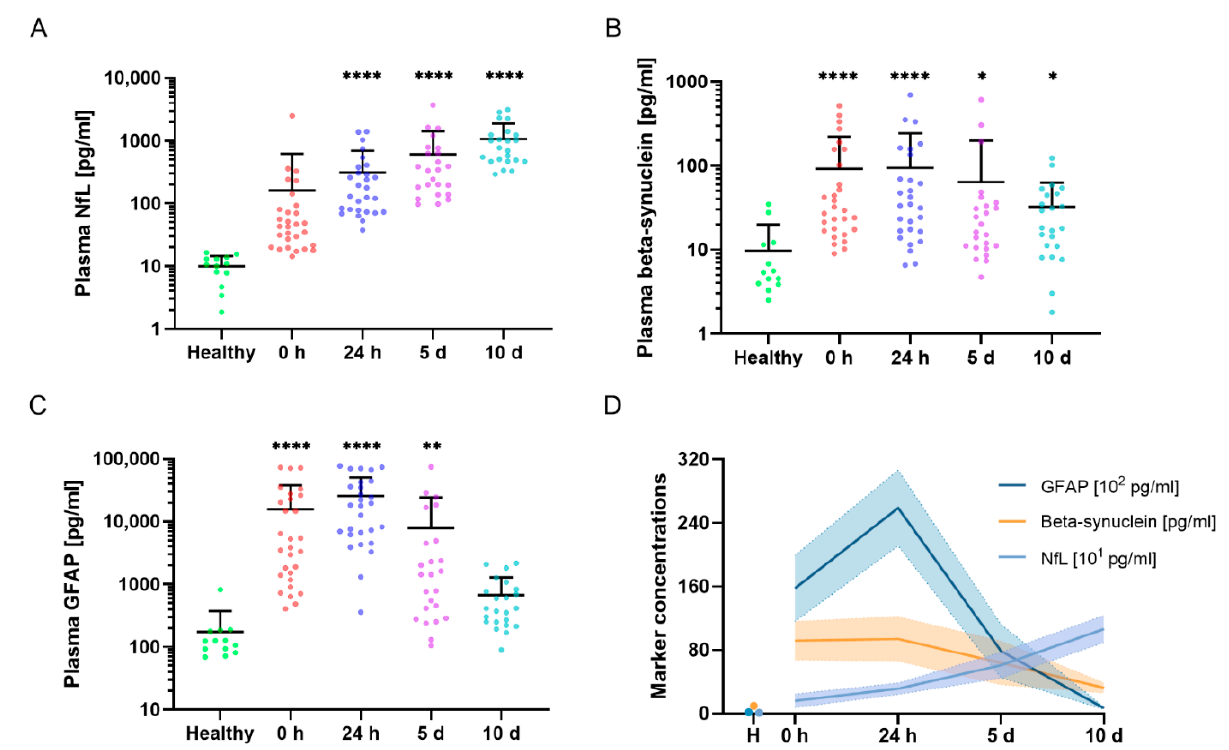
Figure 1. Systemic marker concentrations in the time course after severe injury. ( A – C ) Plasma NfL ( A ), beta-synuclein ( B ), and GFAP ( C ) concentrations in the time course after severe trauma compared to levels in healthy volunteers. Scatter plots are displayed for the individual sampling dates. The mean concentrations + SD are illustrated in ( A – C ). Groups were compared by Kruskal–Wallis test and Dunn’s post hoc test. **** p < 0.0001, ** p < 0.01, * p < 0.05 vs. healthy volunteers. ( D ) Time